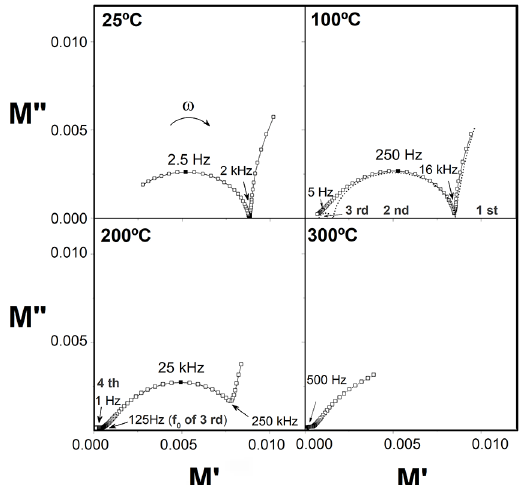
Figure 11. Results of modulus immitance for sample 600–0 according to temperature of